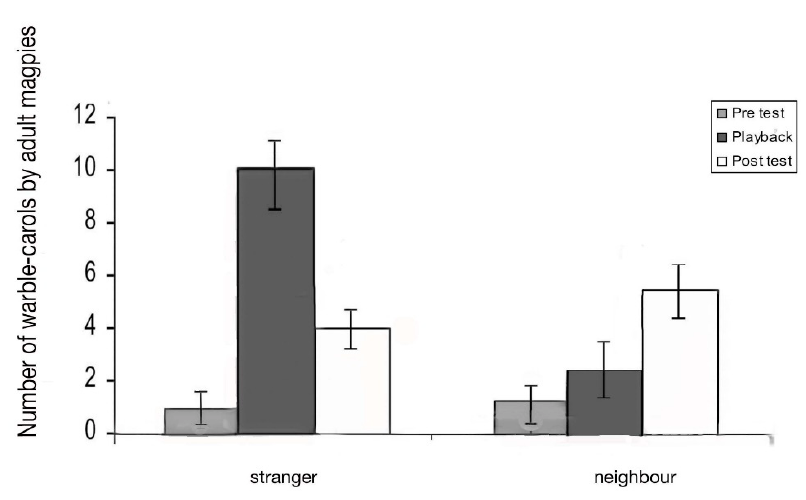
Figure 12. Vocal response by adult magpies ( N = 10) to warble/carol playback over a 15-min test period. Response to playback of the call of a stranger is significant. Vocal responses during playback dropped off quickly once the sound stimulus was removed ( p = 0.03). To neighbours there was barely a response during playback but a stronger response after the stimulus removal ( p = 0.018).